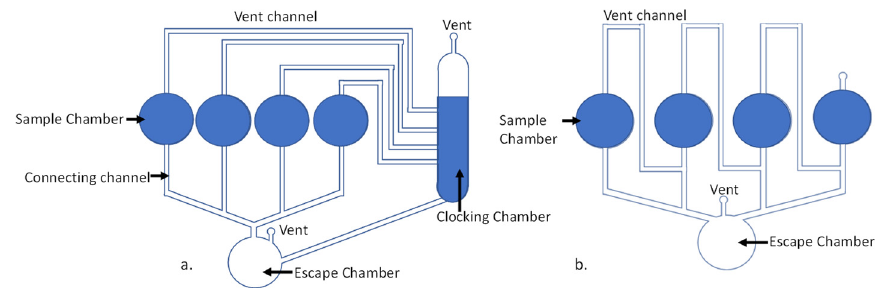
Figure 6. ( a ) The clocking chamber-based design. ( b ) Serial chamber-based valve design. Source: Reconstructed from publication cited [31]. Permission was granted by the publisher to reproduce.